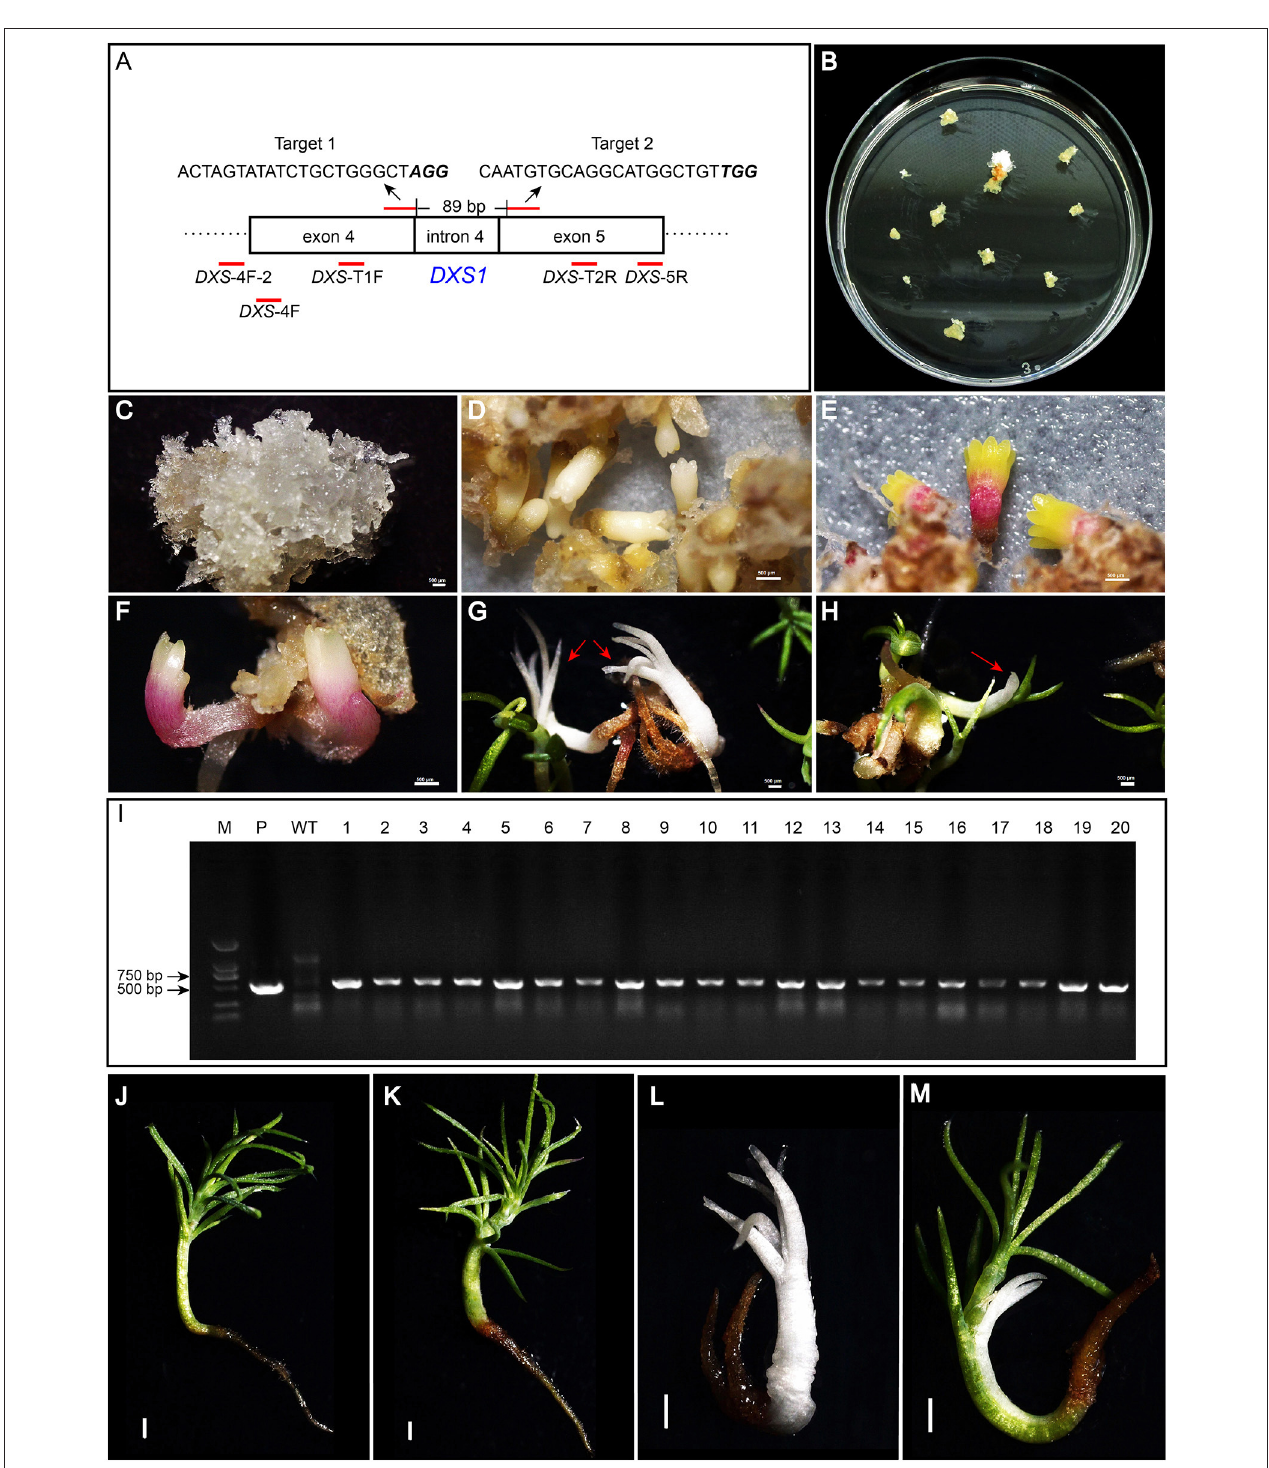
FIGURE 2 | Target sites in the DXS1 gene and regeneration of transgenic somatic embryo (SE) plants. The sequences of two target sites in the DXS1 gene and the primers used for the detection of mutations were shown in (A) . Letters in italic bold type were PAM sites. The primers were shown under the DXS1 gene with their names and positions indicated. Hygromycin-resistant embryogenic tissue was obtained about 4 weeks after transformation (B) . Resistant embryogenic tissues proliferated quickly on the selection medium (C) . Cotyledonary SEs developed after 4 weeks of maturation (D) and further converted into SE plants on the germination medium (E–H) . (E,F) showed the germination of green and albino SE plants, respectively. (G,H) showed the growth of albino and mosaic SE plants after 20 days on the germination medium, which was indicated with red arrows. (I) showed the results of PCR amplification of hpt gene in the transgenic SEs (1–20), wild-type SEs (WT), and the positive control PgCas9/PaU6 ( DXS1 ) (P). SE plants of wild type and transgenic types, including green, albino, and mosaic ones after 65 days on the germination medium, were shown in (J–M) , respectively. All bars equal to 500 µ m in (C–H) , while bars in (J–M) equal to 1,000 µ m.